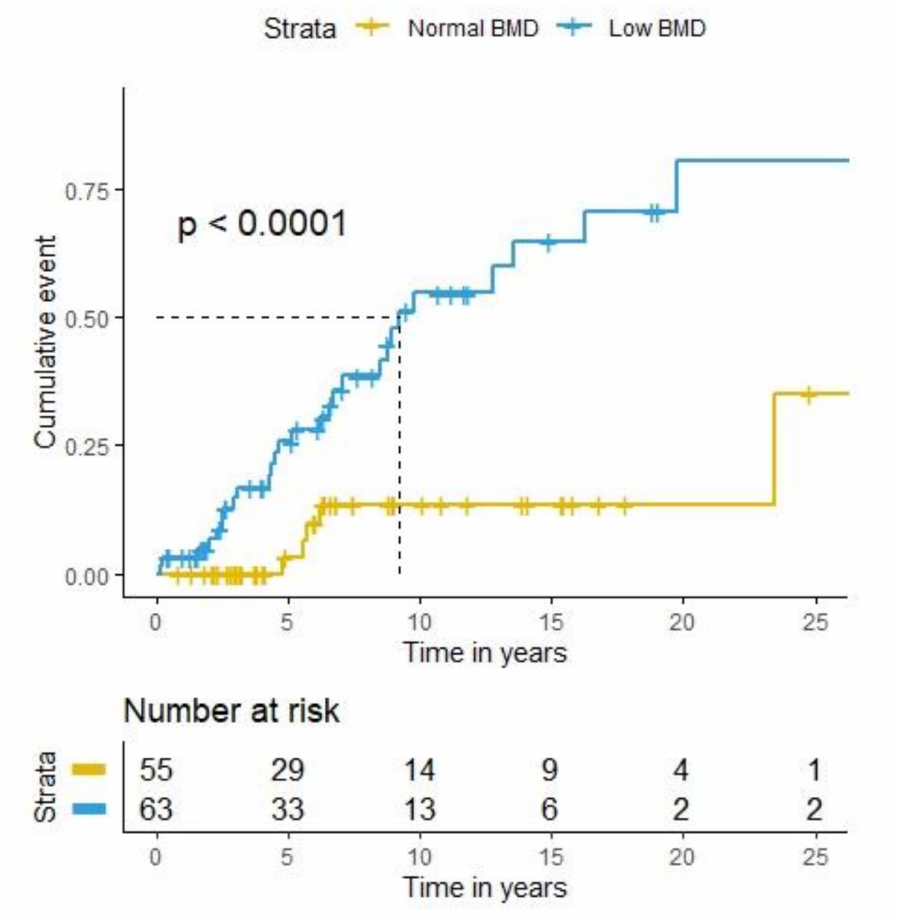
Figure 3. Kaplan–Meier curve of estimated cumulative fracture events for patients stratified by bone mineral density (normal BMD vs. low BMD). BMD = bone mineral